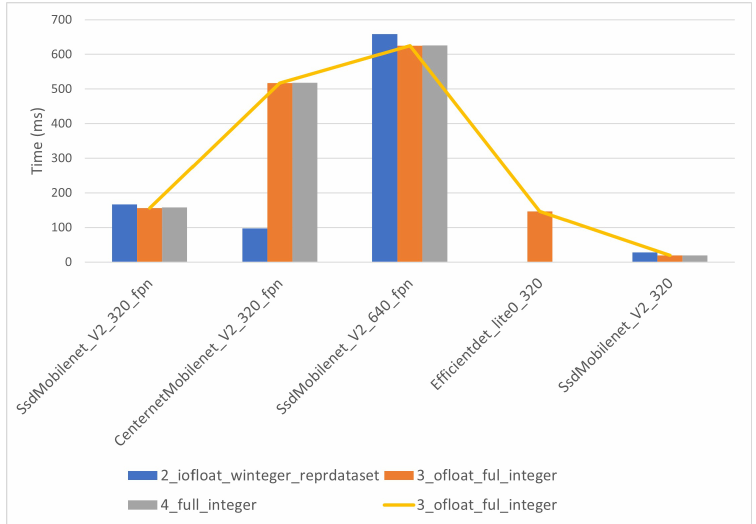
Figure 19. EdgeTPU inference time for co-processor models.